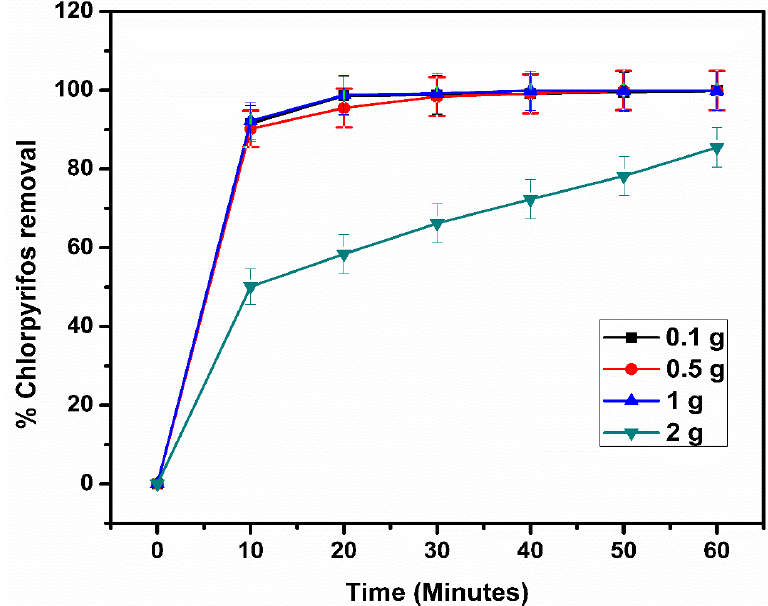
Figure 15. E ff ect of the initial photocatalyst loading on the photodegradation of Figure 15. Effect of the initial photocatalyst loading on the photodegradation of chlorpyrifos.